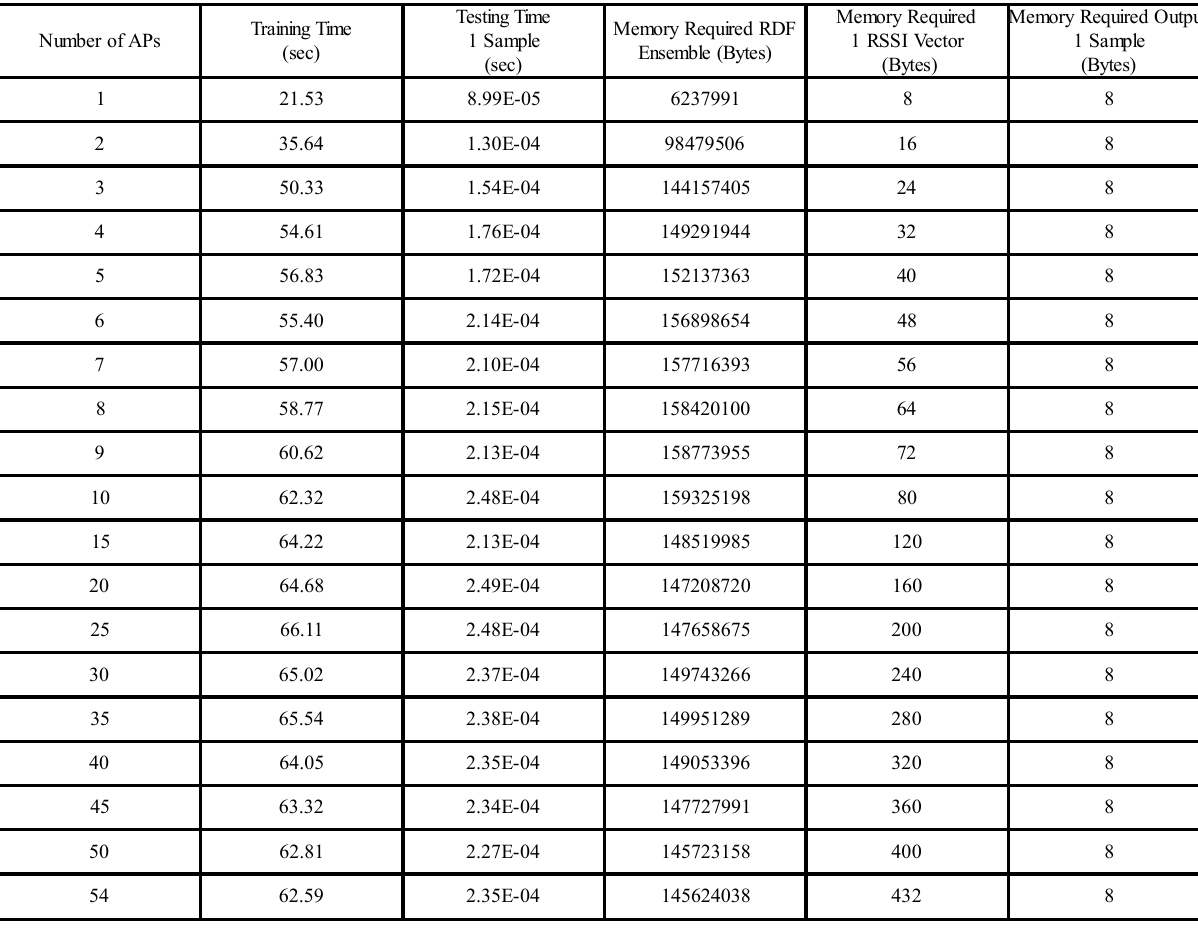
TABLE 6. COMPLEXITY ANALYSIS WITH INCREASING